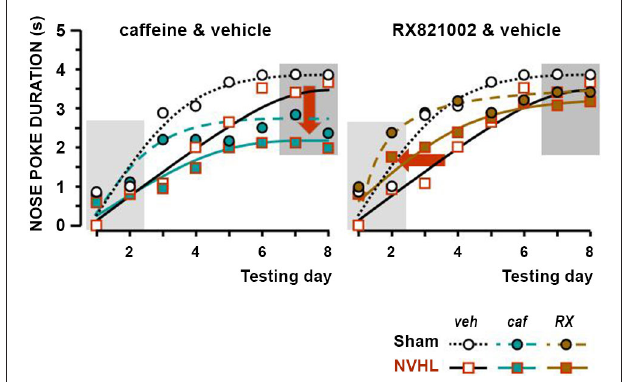
FIGURE 3 | Effect of the treatments in the associative learning test . The two graphs show the duration of nose poking in the food magazine during the 5 s before food was delivered (ceiling = 5 s). The X -axis depicts the sequence of daily training sessions in which 10 s of the cue preceded food delivery. The Y -axis presents the mean nose poke duration for each daily session (1–8 days). Data of sham-lesioned rats were represented as circles and dotted lines, those of NVHL rats as squares and full lines. The white symbols correspond to the reference data (vehicle), the green symbols to the effect of caffeine, and the brown symbol to the effects of RX821002. The standard errors were not plotted for clarity (see statistical computations in the Result section). The dark backgrounds signal respectively the initial learning and final stable performances. The arrows point to the changes (left graph: effect of caffeine on the final performance and, right graph: effect of RX821002 on the learning